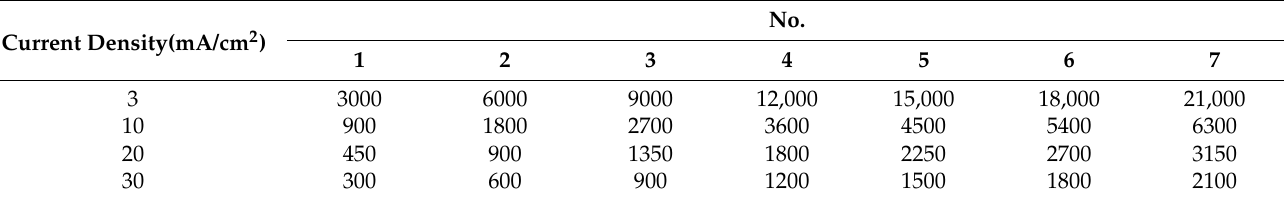
Table 2. Estimated power on time of each test sample.